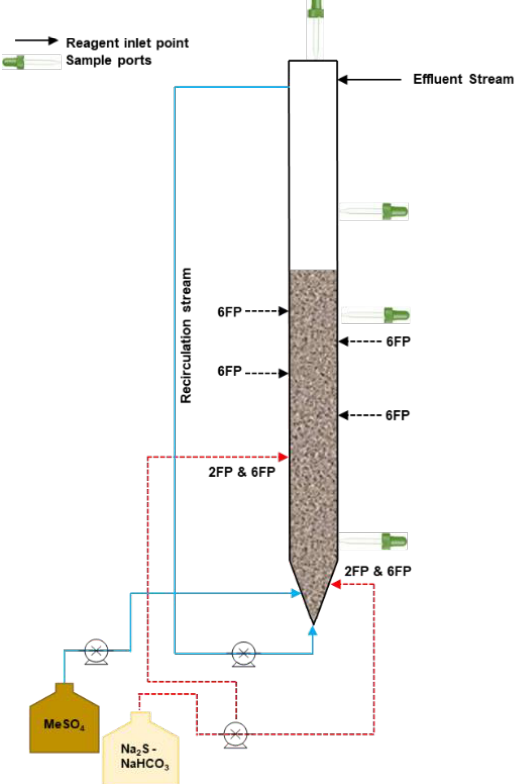
Figure 3. Fluidized bed reactor prototype used by Mokone and colleagues [74] to assess the supersaturation control in metal sulfide precipitation. FP represents the sulfide feed points defined in the study. Adapted from [74].